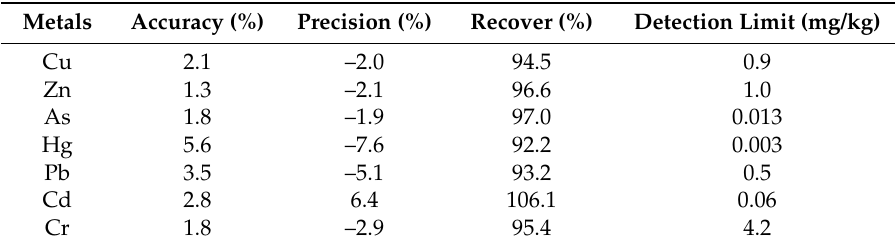
Figure 1. Sampling sites of wastewater treatment plants (WWPTs) locations in Shanxi province, China. Table 1. Analytical accuracy, precision, recover and detection